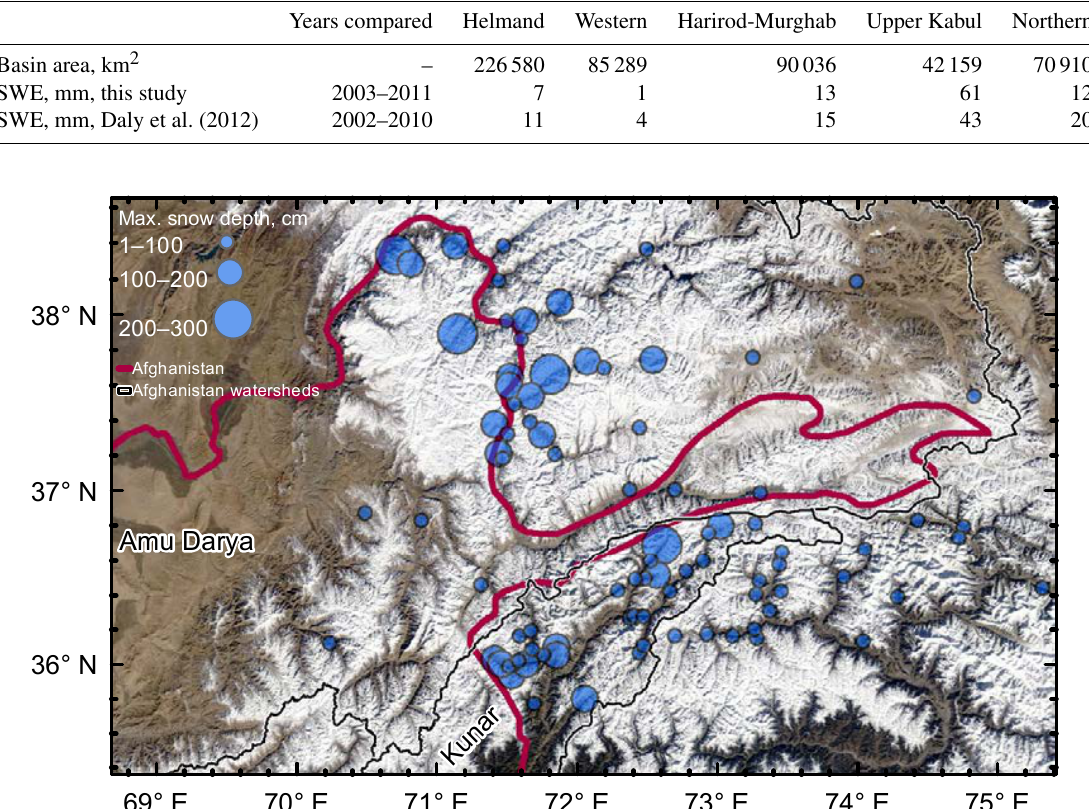
Figure 3. Maximum snow depth from WY 2017 manual measurements at AKAH stations in Afghanistan, Pakistan, and Tajikistan overlaid on a MODIS true color